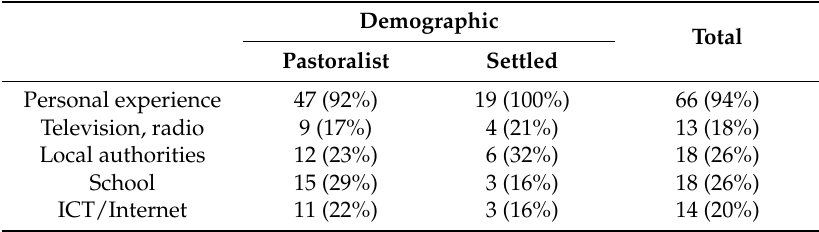
Table 4. Information sources on biodiversity, conservation and park